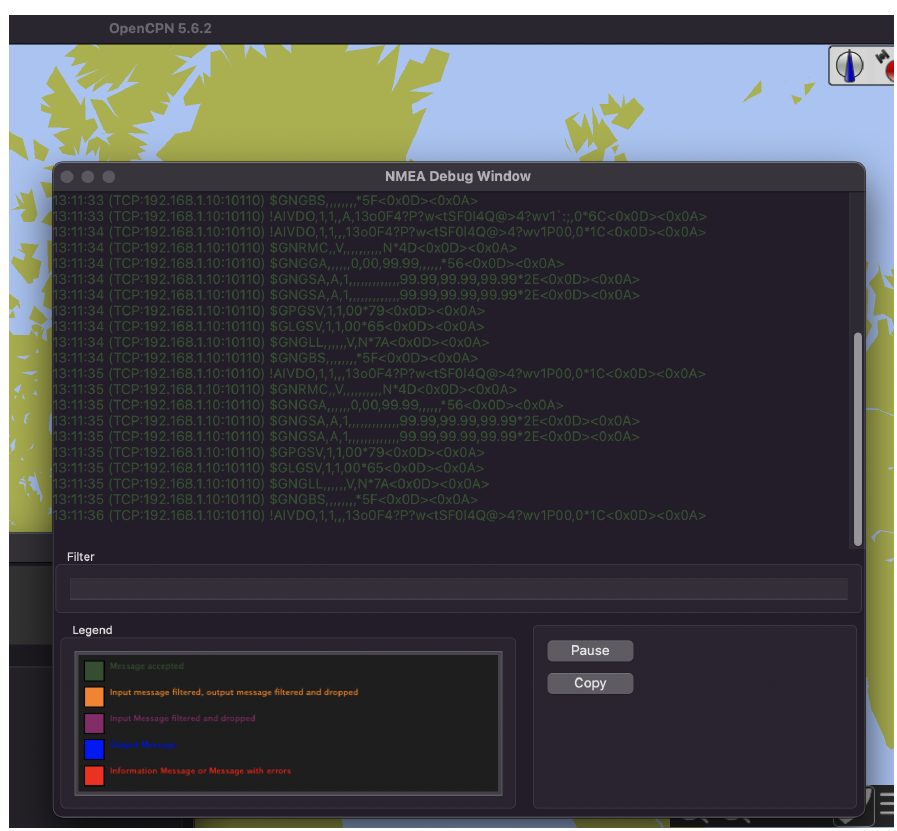
Figure 8. OpenCPN debug window with received NMEA